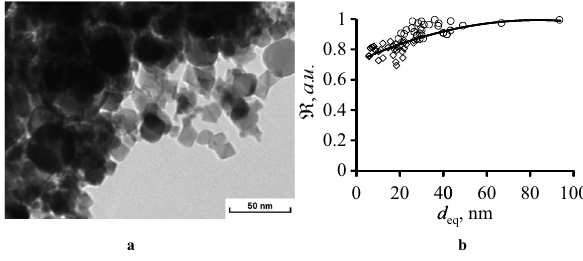
Figure 1: ( a ) Transmission electron microscopy image of cerium oxide nanoparticles obtained by laser ablation. ( b ) Dependence of the degree of nanoparticles' sphericity on their